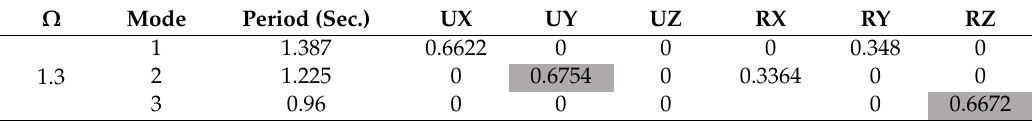
Table 9. Modal Participating Mass Ratio Buildings (with b / r = 2.45, 1 < Ty < 2 s, Ω = 1.3).